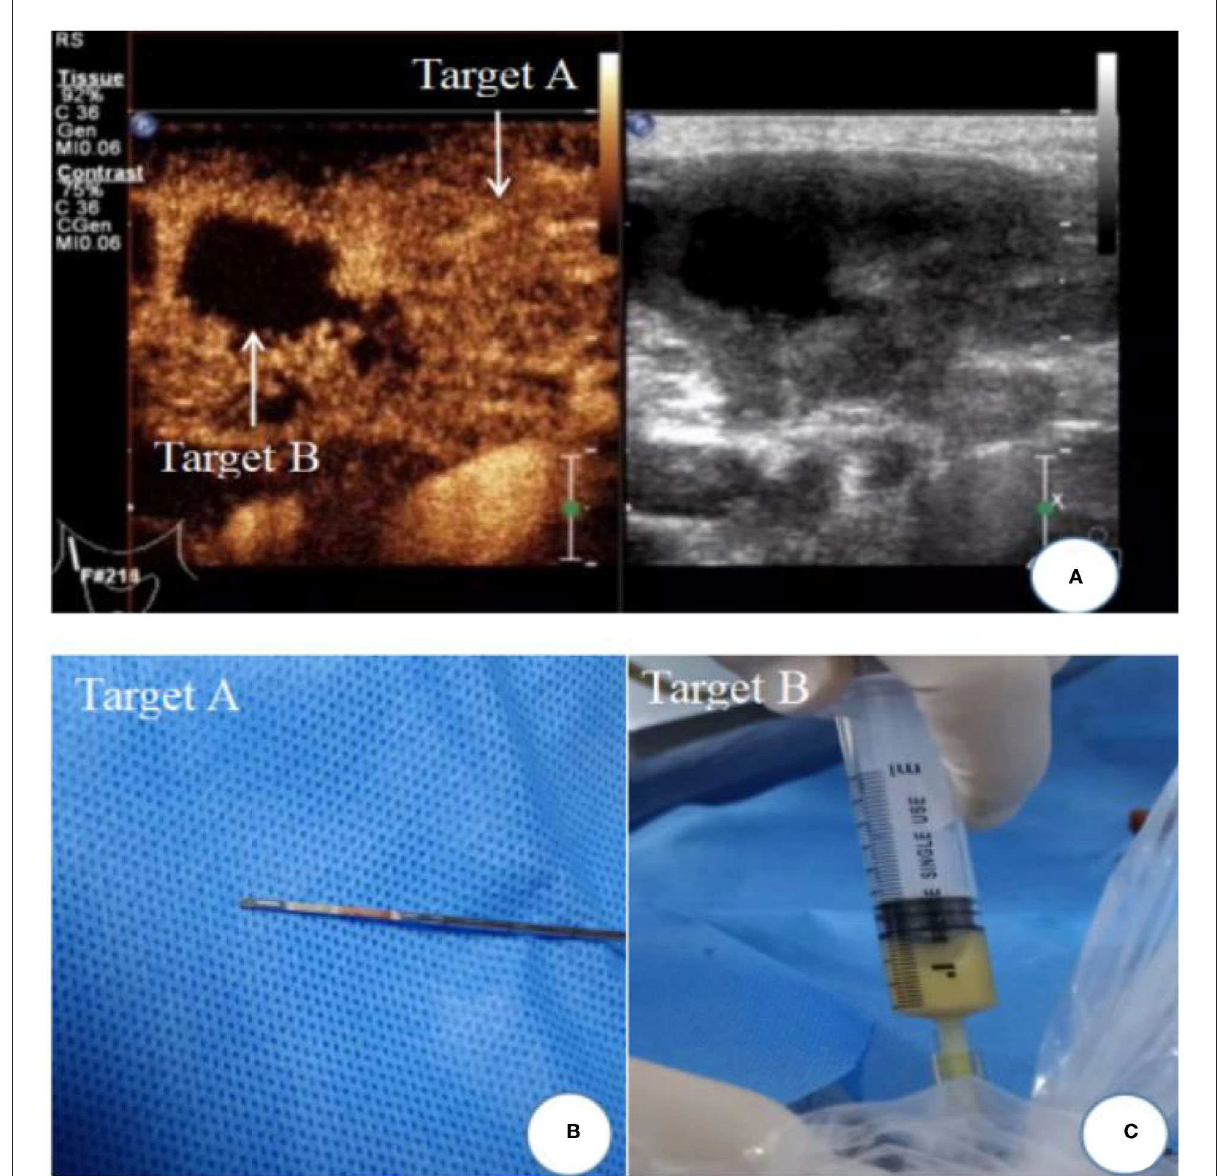
FIGURE1 Ultrasound image of cervical lymph node tuberculosis. (A) Contrast-enhanced ultrasound showed uneven enhancement of lymph nodes, Target A: uneven enhancement areas; Target B: non-enhanced areas of caseous necrosis; (B) biopsy tissue specimen of enhanced area; (C) area without enhancement with fine-needle aspiration caseous